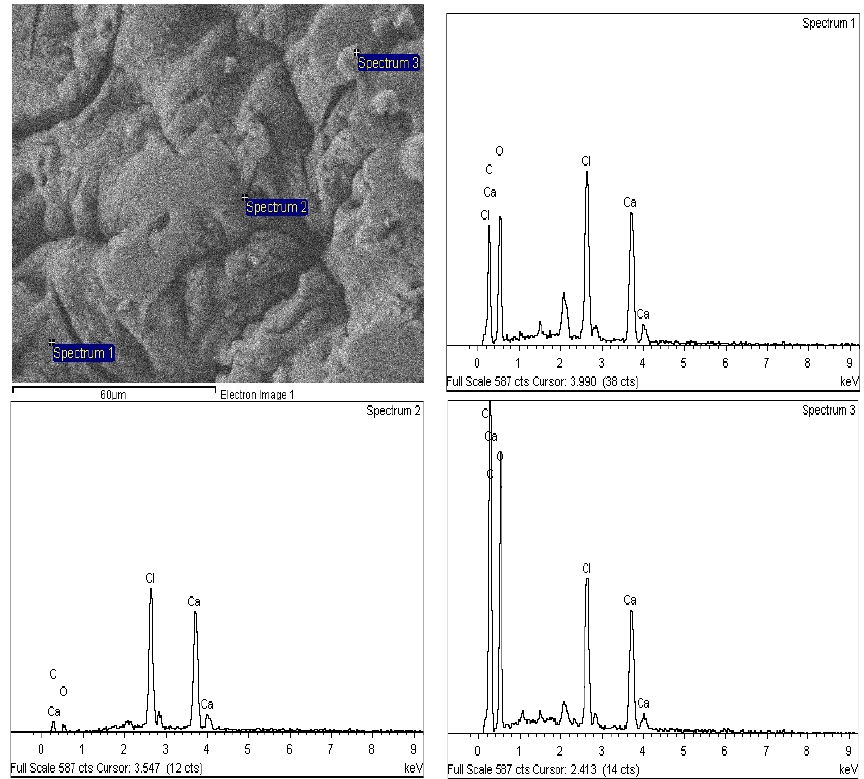
Figure 4. EDXs spectra for SA − β − CD/CNTs hybrid hydrogel at three different regions.